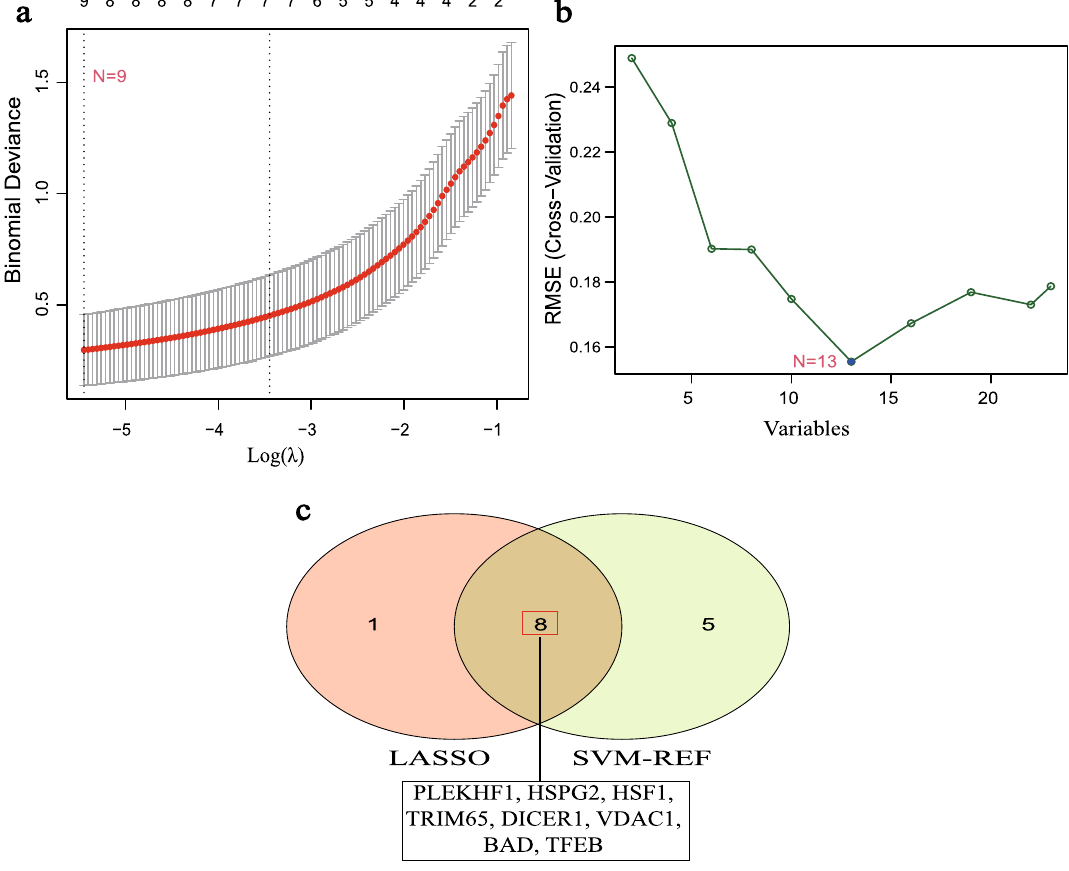
Figure 6. Screening of diagnostic biomarkers for DCM by machine learning algorithms. ( a ) Screening of optimal genes by LASSO regression model. ( b ) Plot of the best gene selected by SVM-RFE algorithm. ( c ) Venn diagram embodying the eight diagnostic biomarkers common to both machine learning algorithms. LASSO, least absolute shrinkage and selection operator; SVM-RFE, support vector machine-recursive feature